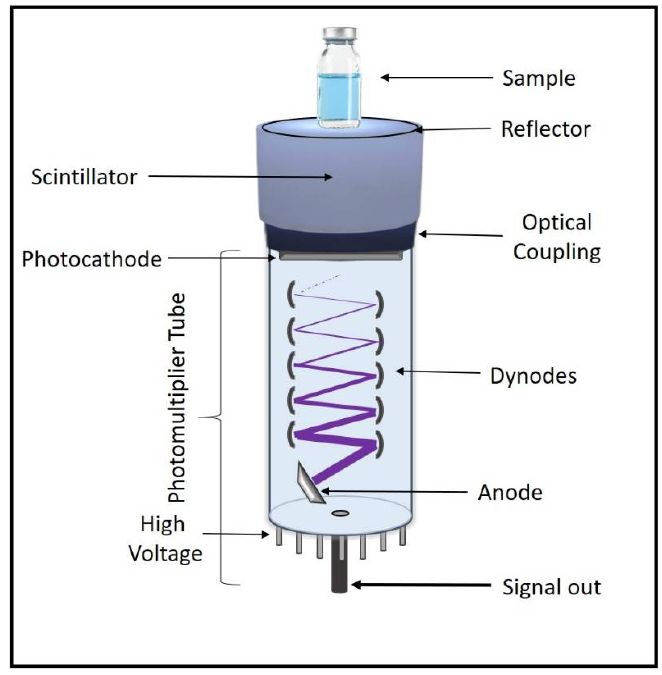
Figure 5. General diagram of the scintillator detector.